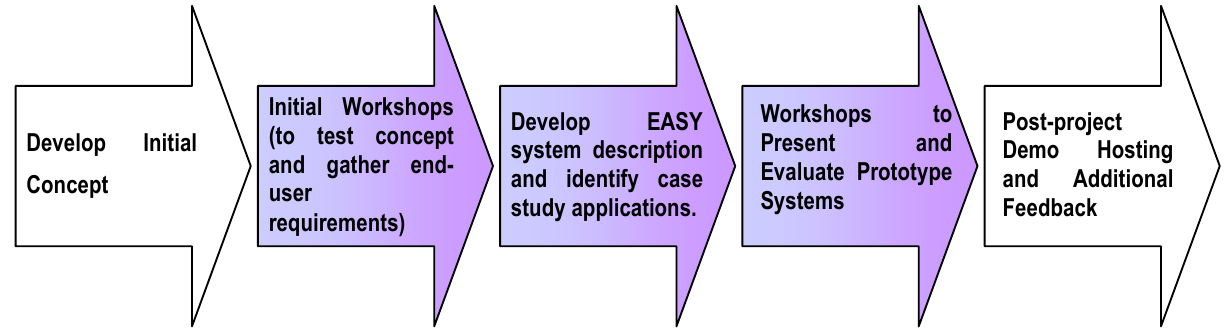
Figure 1. EASY plan schematic. The stages of the consultation and evaluation processes are highlighted in